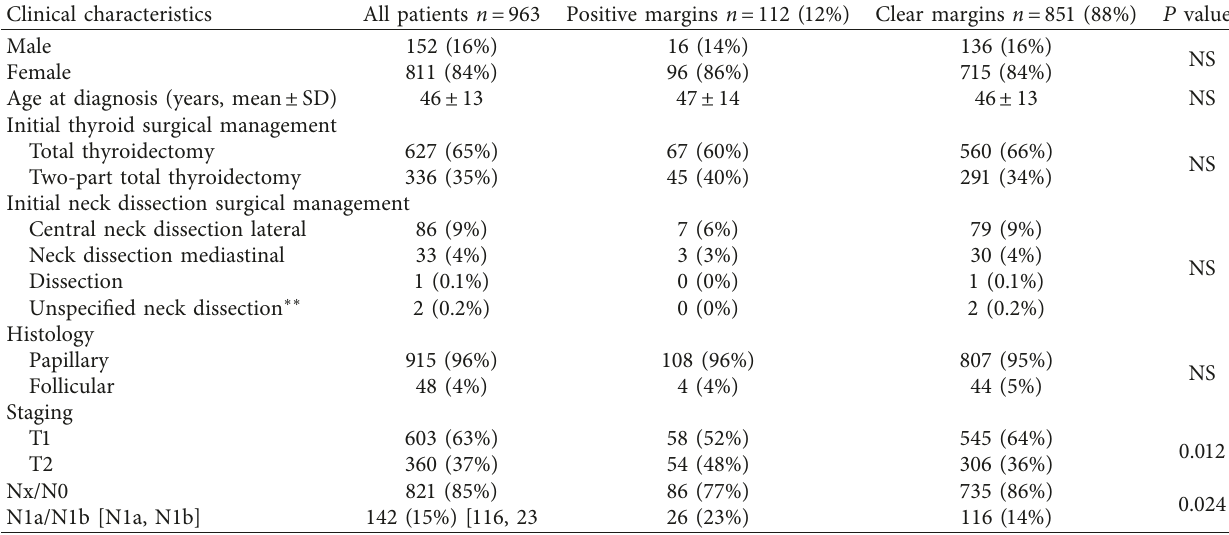
Table 1: Clinical characteristics.